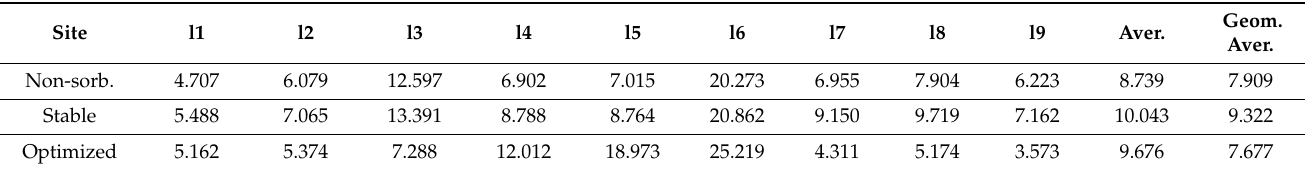
Table 3. Longitudinal dispersivities (m) for test sites postprocessed from the non-sorbing tracer, from the average of the stable tracers (“stable”) and the optimized values. There are also (arithmetic) and geometric averages over all sites.